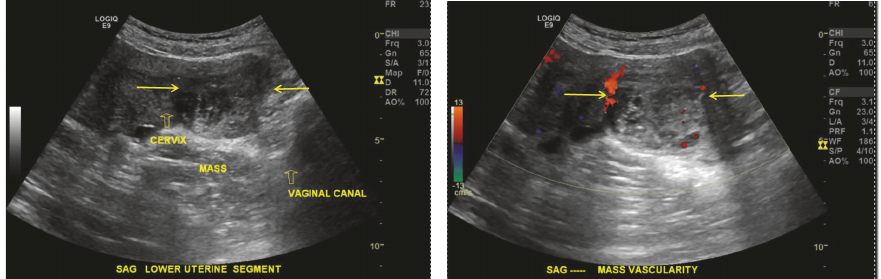
Figure 2: Transvaginal ultrasound. (a) Gray scale image shows a mixed echogenicity mass (arrows) with small hypoechoic cystic areas (3.0 MHz) 10 cm. (b) Color Doppler image shows minimal vascularity. Magnitude: 3 MHz.